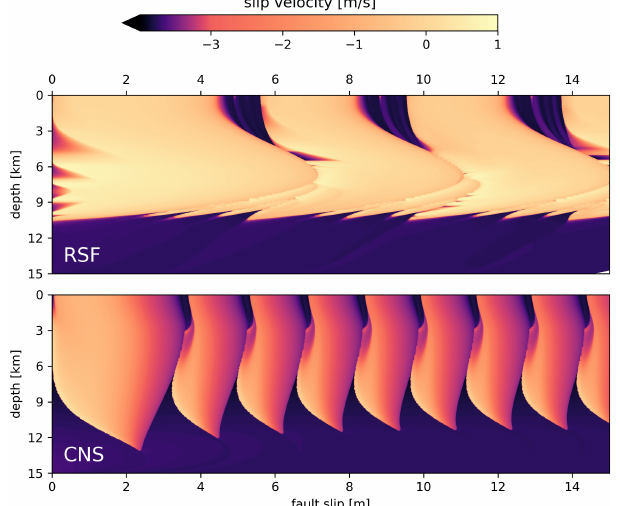
Figure 9. Numerical simulation of the spatio-temporal evolution of slip rates on a simulated strike-slip fault based on rate-and-state fric- tion (RSF; top) and on the CNS model (bottom). Brighter colours indicate higher slip rates, and dark purple indicates slow creep. While the RSF-based simulation exhibits large and fast earthquakes, the CNS-based simulation exhibits mostly small slow-slip events. After Van den Ende et al. (2018).